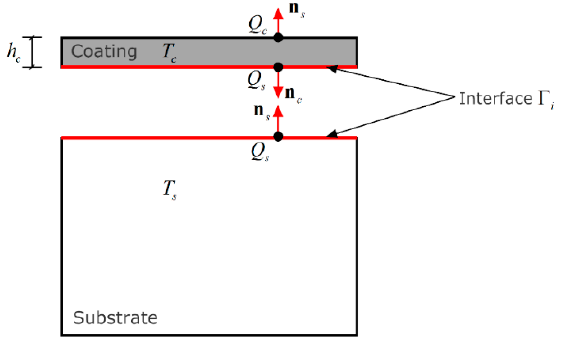
Figure 3. Configuration of the single-layered homogeneous coating/substrate system.